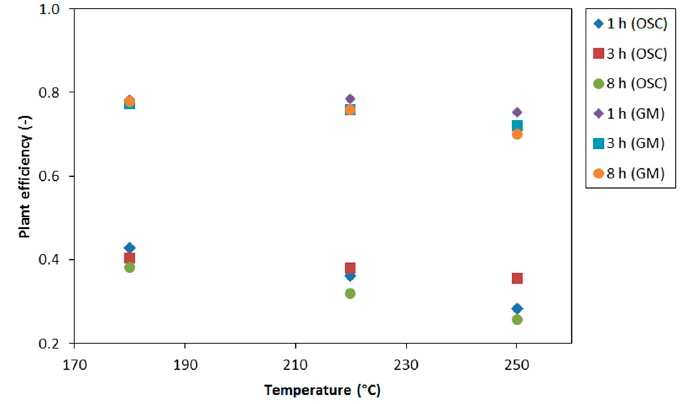
Figure 5. Plant efficiency at different HTC temperatures (180, 220, 250 °C) and residence times (1, 3, 8 h) for OSC and GM.